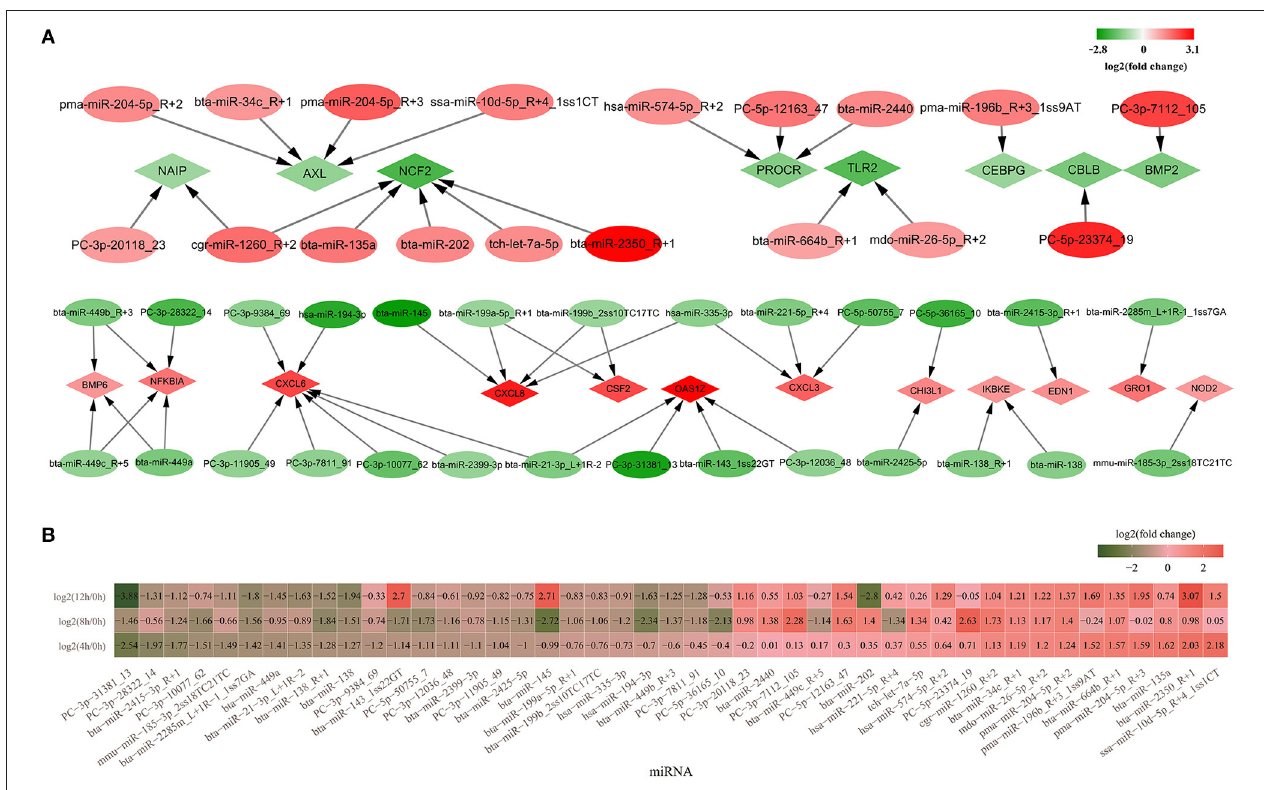
FIGURE 6 | The differentially expressed miRNAs involved in inflammation and immunity. (A) Forty-five significantly up- or down regulated miRNAs involved in inflammation and immunity and their targeted mRNAs. Diamond represents mRNAs and the oval represents miRNAs; (B) The heatmap of relative expression for 45 significantly up/downregulated miRNAs in 4, 8, and 12h bMECs. Green represents the downregulation and red represents the